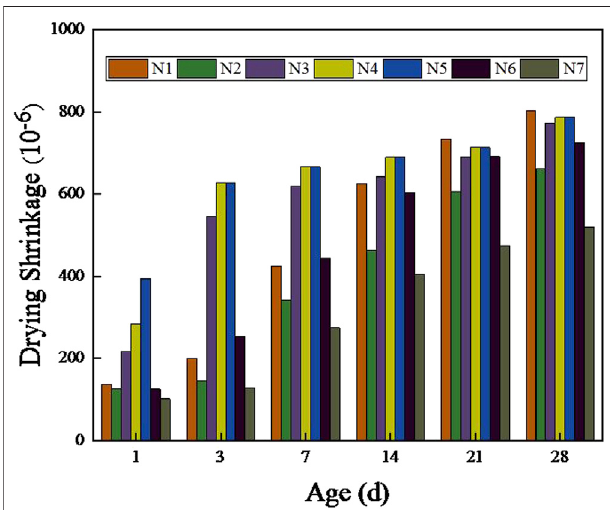
FIGURE 5 | Effect of Sika on drying shrinkage of